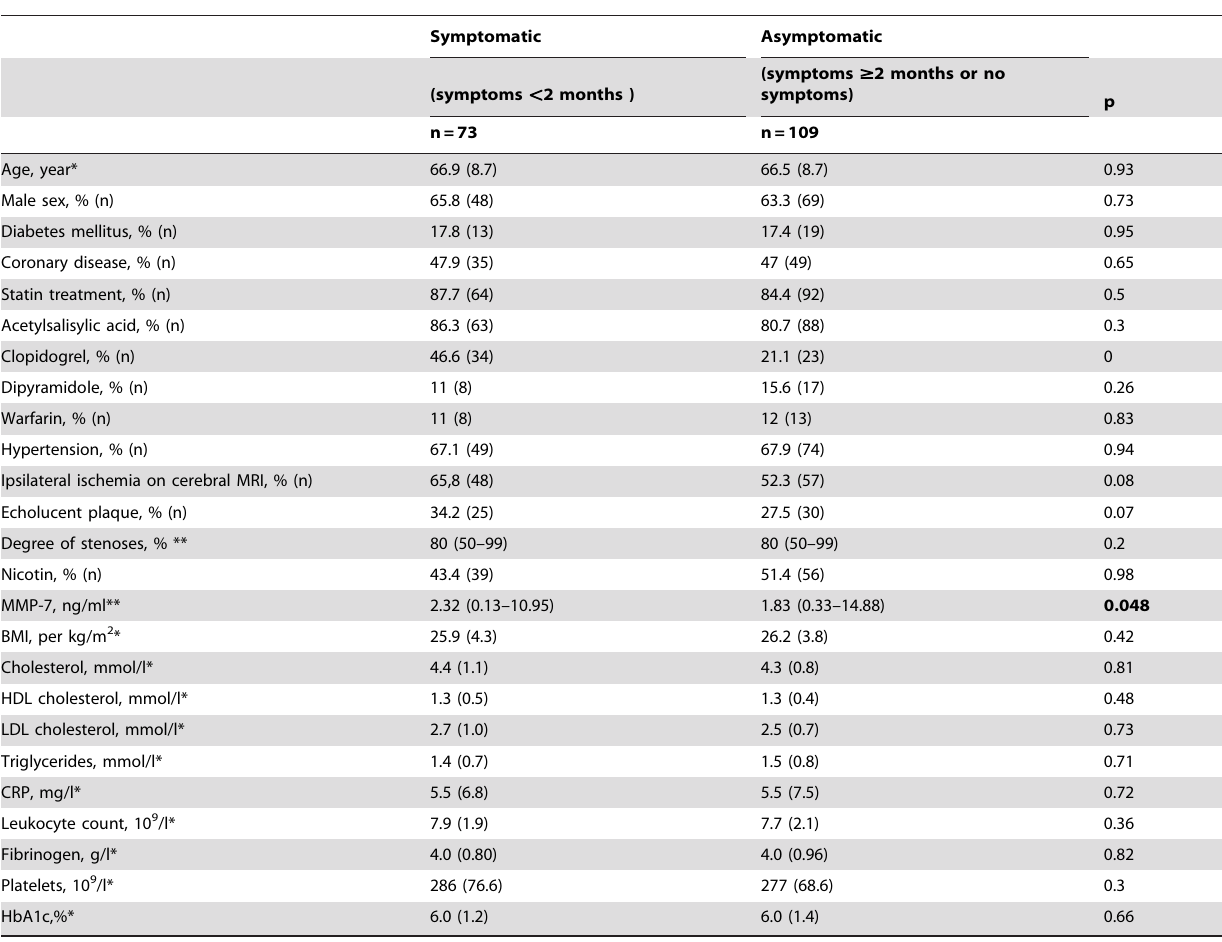
Table 1. Baseline variables in patient groups according to symptomatology (n